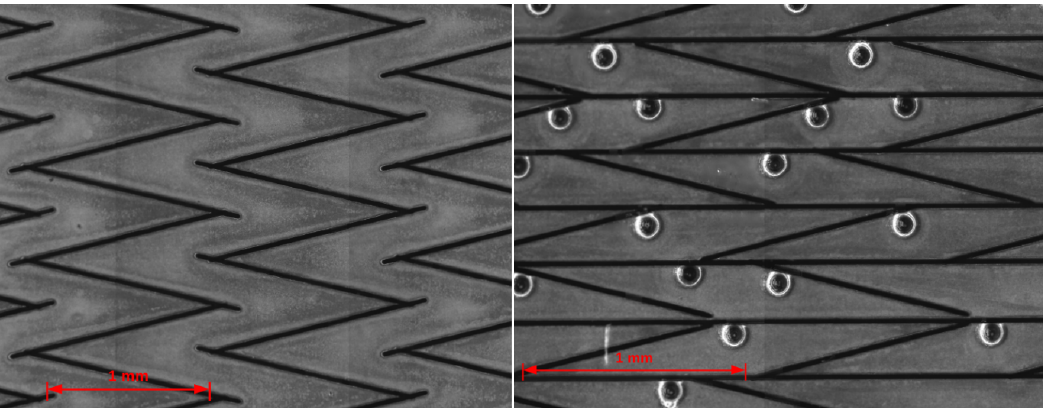
Figure 7. Typical readout with 1D zigzag geometry and 2D zigzag geometry taken with an optical microscope. The holes in the 2D pads are via connections. Etching of the pads was done with a laser. 2D patterns are currently under